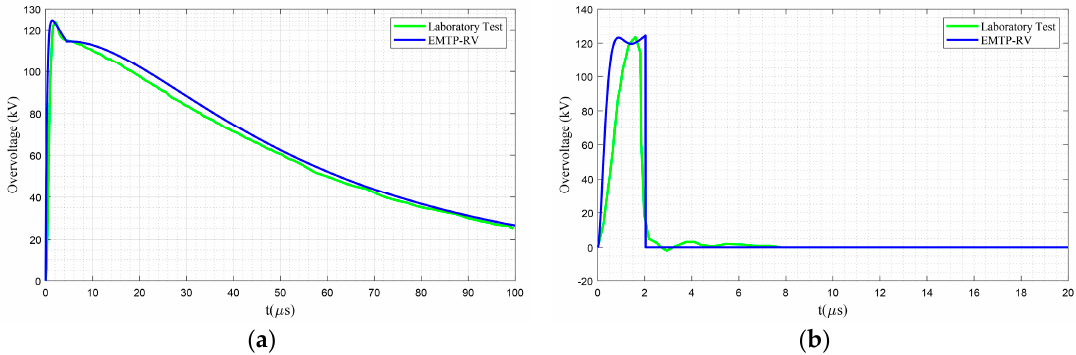
Figure 8. ( a ) Applied nonstandard 125 kV lightning impulse; ( b ) Measured overvoltage stress in the presence of spark gap [45].